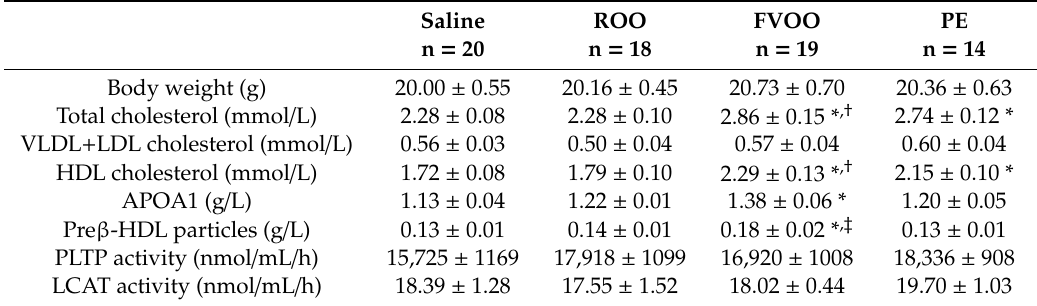
Table 1. Serum and HDL parameters in female C57BL / 6 mice administered saline, ROO, FVOO or PE for 14